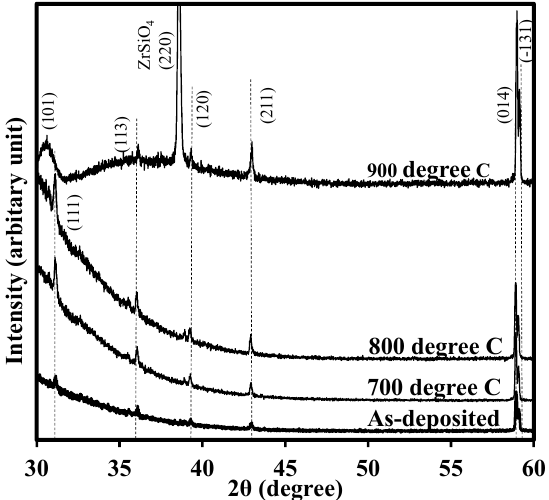
Figure 8. XRD patterns (with normal angle) for the as-deposited, 700 °C, 800 °C and 900 °C annealed samples. The thickness of the device under test was about 22 nm. For the as-deposited one, the thin films was poly-crystalized with weak reflections. When the RTA temperature reached 900 °C, more noticeable diffraction peaks